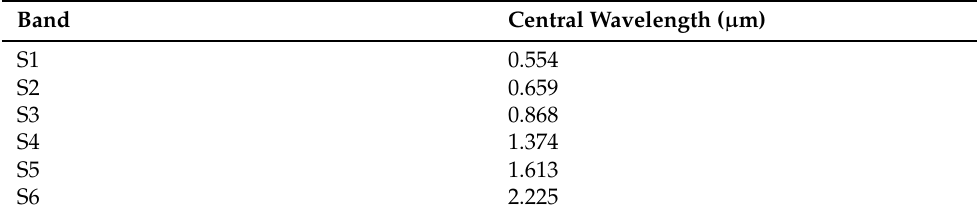
Table 1. Central wavelength of SLSTR bands S1 to